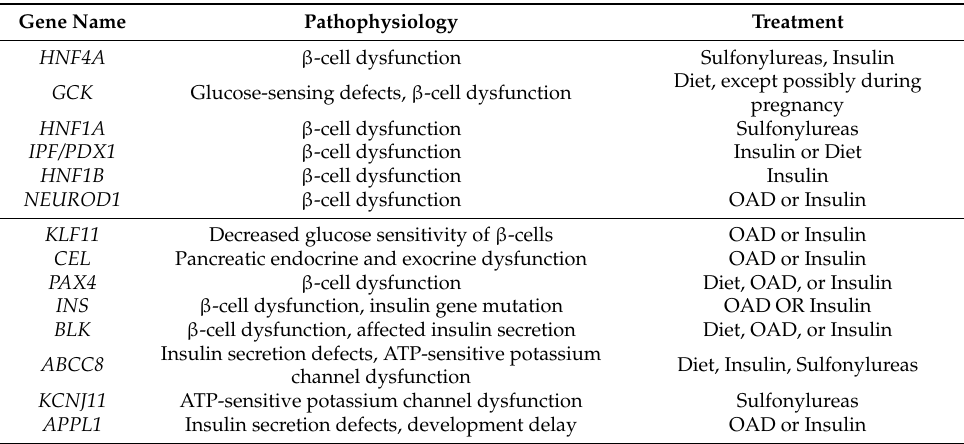
Table 2. Summaries of MODY subtypes and